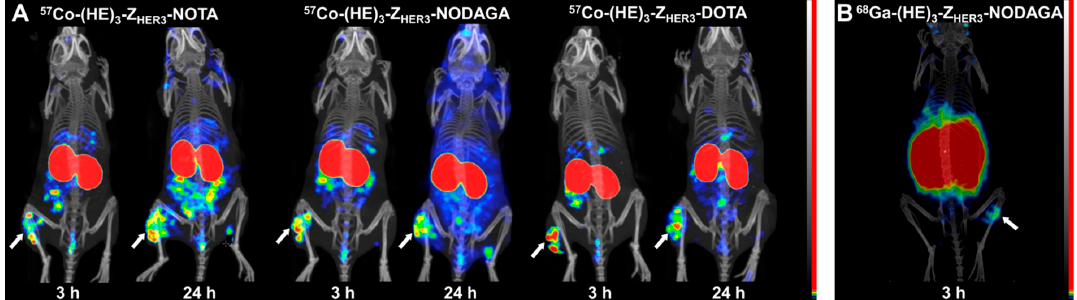
Figure 6. ( A ) Micro-single-photon emission tomography/computed tomography (microSPECT/CT) imaging of [ 57 Co]Co-(HE) 3 -Z HER3 -X at 3 and 24 h pi in mice bearing HER3-expressing BxPC-3 xenografts. [ 57 Co]Co-(HE) 3 -Z HER3 -DOTAGA was excluded from the imaging study because of unfavorable biodistribution prolife. ( B ) Micro-positron emission tomography/computed tomography (microPET/CT) imaging of [ 68 Ga]Ga-(HE) 3 -Z HER3 -NODAGA 3 h pi in a mouse with HER3-expressing BxPC-3 xenograft. Images are displayed as maximum intensity projections (MIP). White arrows indicate the HER3-expressing BxPC-3 xenografts.